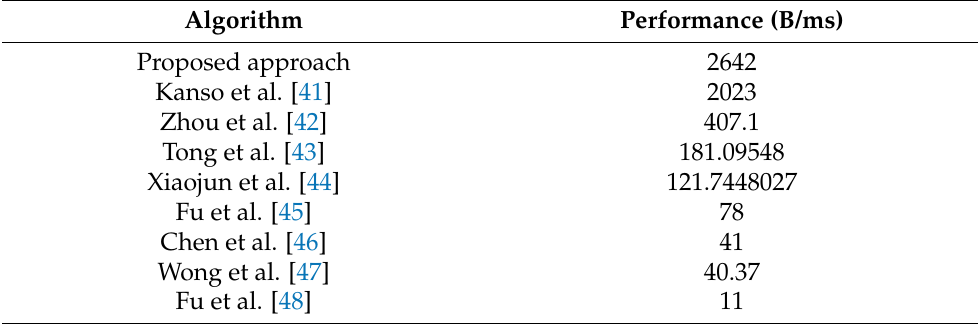
Table 2. Results of performance comparison.